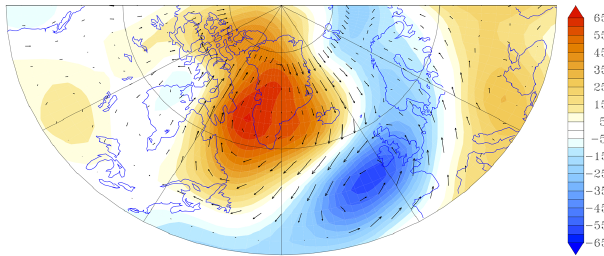
Fig. 11. 700hmb geopotential height (m) and wind anomaly for June, July and August 2012 from the NCEP/NCAR Reanalysis data.